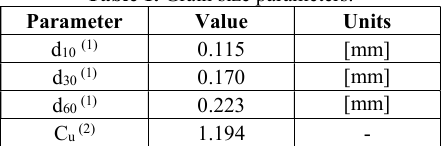
Table 1. Grain size